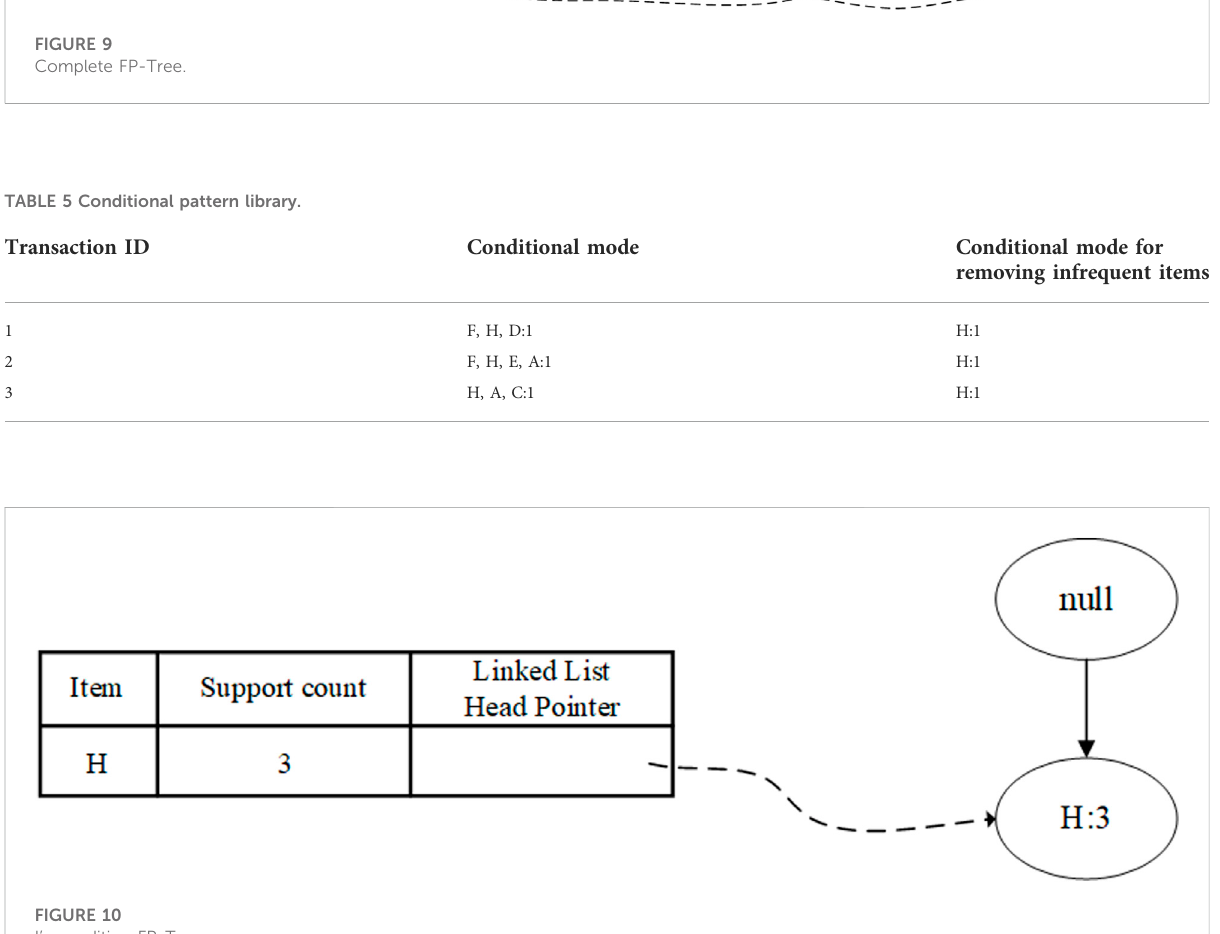
FIGURE 9 Complete FP-Tree.